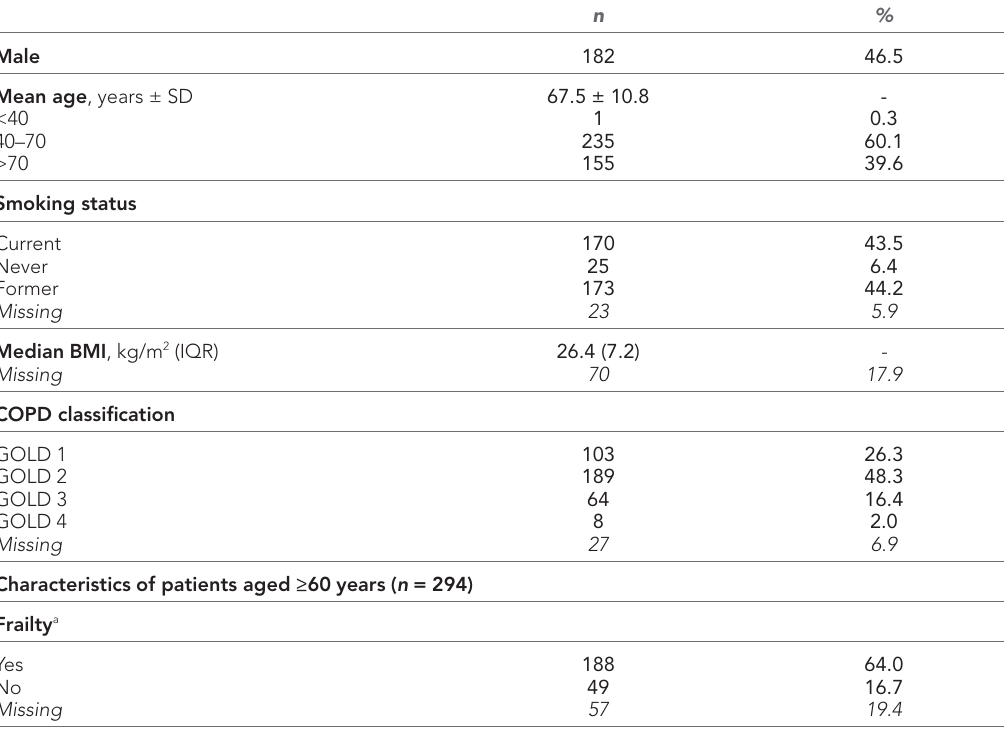
Table 1 Patients characteristics ( n =